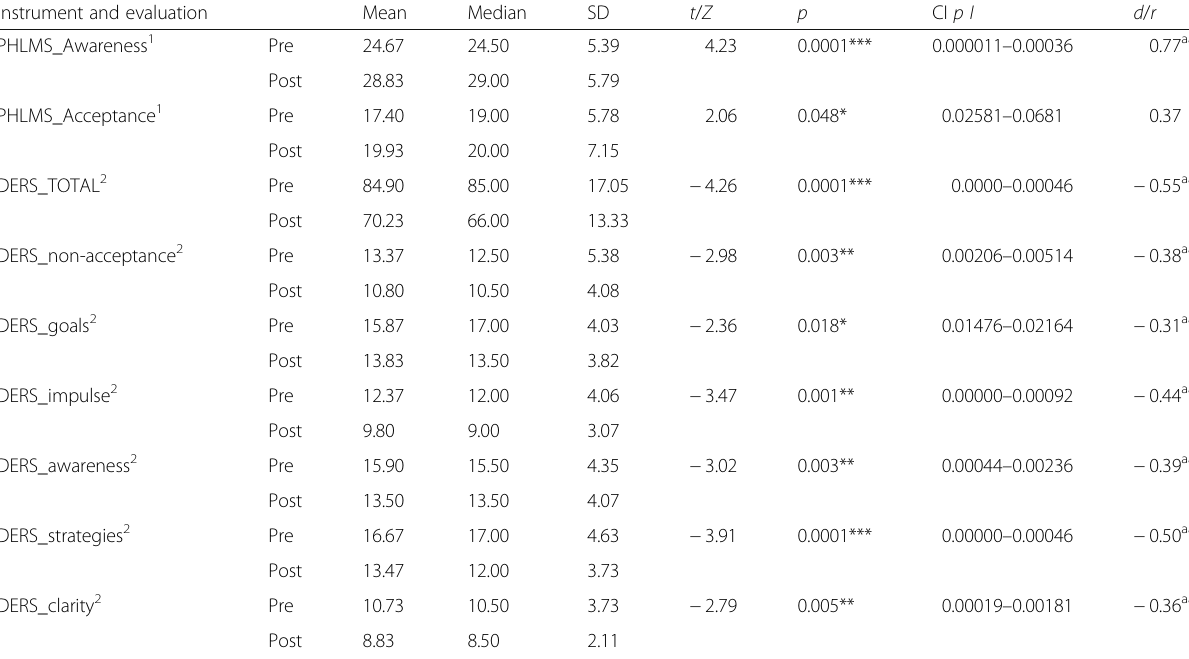
Table 4 Pre- and post-test effects of a brief mindfulness-based intervention on senior students ( n = 30) Instrument and evaluation Mean